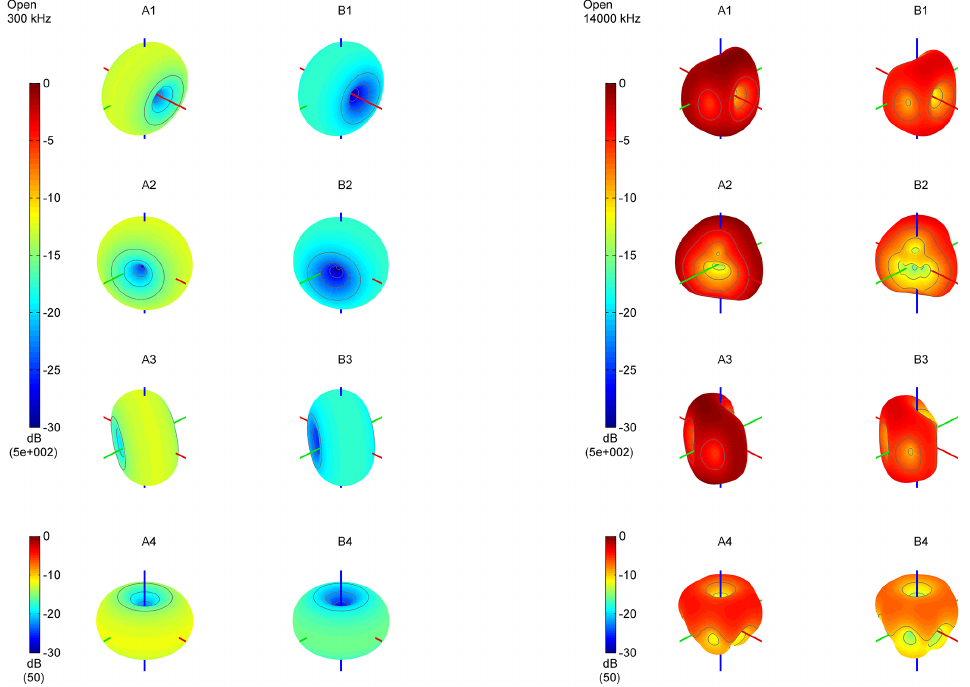
Figure 5. Effective area patterns of boom antennas A 1– A 4 and short cylindrical sensors B 1– B 4 at 300kHz (left) and 14MHz (right).The panels show an oblique view, with the + x axis pointing upwards, the + y axis to the right and towards the observer, and the + z axis to the right and away from the observer The color scale is at 0dB/500m 2 for A 1– A 3 and B 1– B 3 and at 0dB/50m 2 A 4 and B 4.